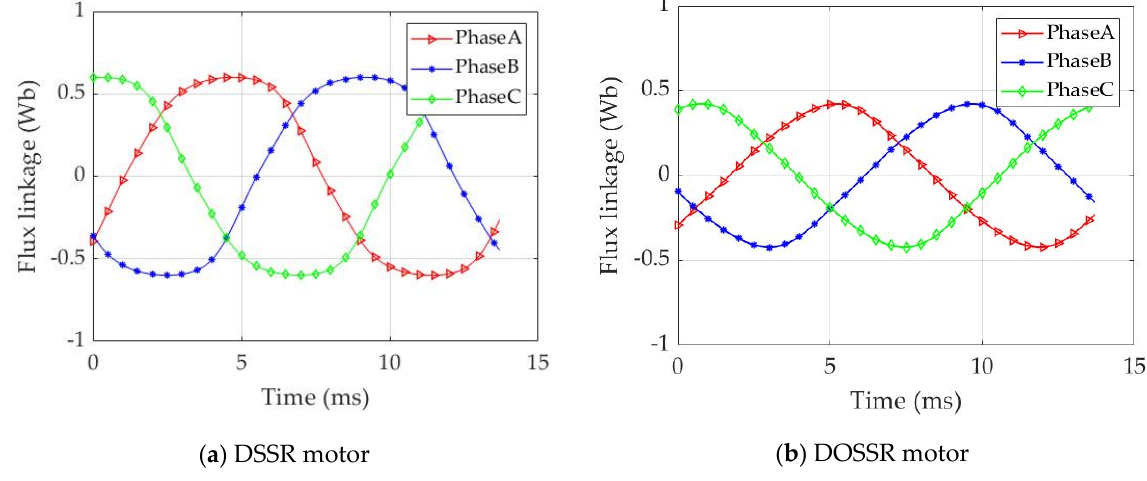
Figure 8. Flux linkage for the DSSR motor and the DOSSR motor (100 A rms, 900 rpm).